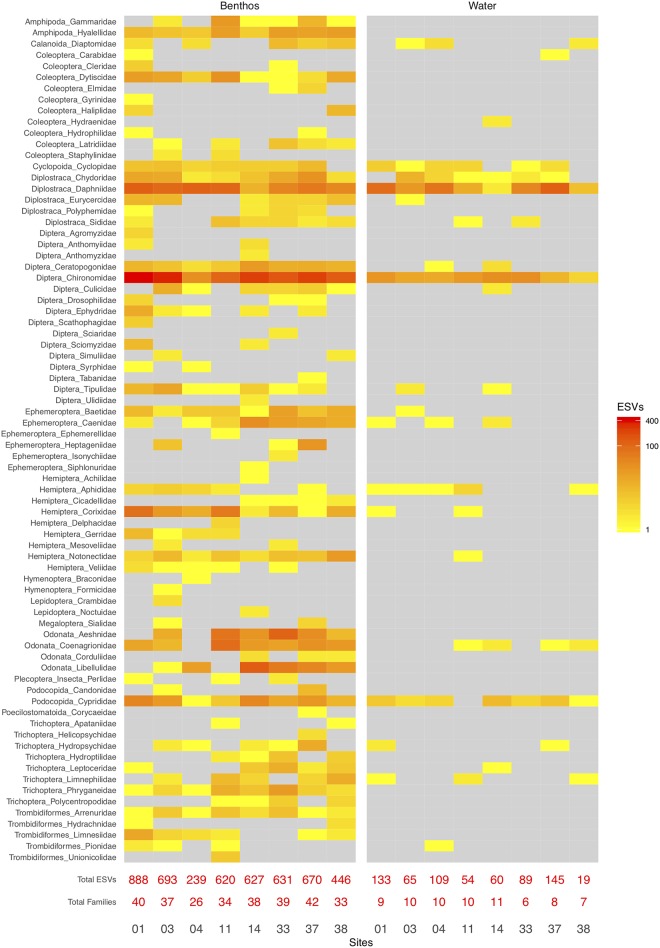
More Ephemeroptera, Plecoptera, Trichoptera, and Odonata family ESVs are detected from benthos compared with water samples.Each cell shows ESV richness colored according to the legend. Grey cells indicate zero ESVs. Only ESVs taxonomically assigned to families with high confidence (bootstrap support > = 0.20) are included. Based on normalized data.